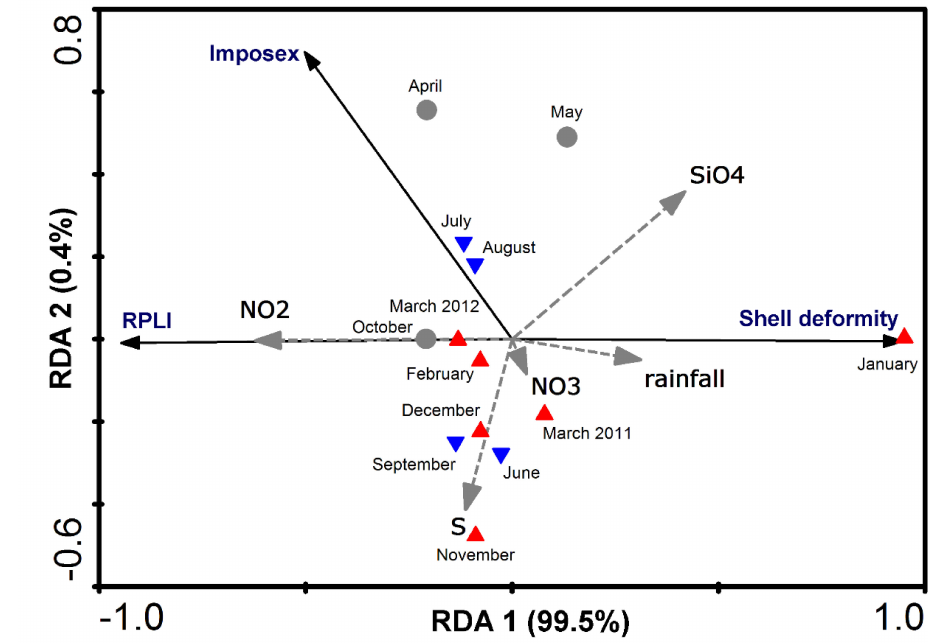
Figure 4. Biplot diagram of constrained RDA with data of stress-related population attributes (full black arrow) and environmental variables (dotted gray arrow). Biological variables (incidence of imposex and shell deformity, and the index of relative penis length—RPLI) were previously selected to control for autocorrelation. A stepwise forward selection criterion of environmental data has included six variables in the RDA that significantly contributed to the model explanation: accumulated rainfall (mm), and nitrogen compounds—nitrate (NO 3 ) and nitrite (NO 2 ), salinity (S), and silicate (SiO 4 ) in the bottom water. Distinct symbols and colors indicate that samples were collected during the warm-rainy ( (cid:78) ), intermediate ( • ), and cold-dry seasons ( (cid:72)